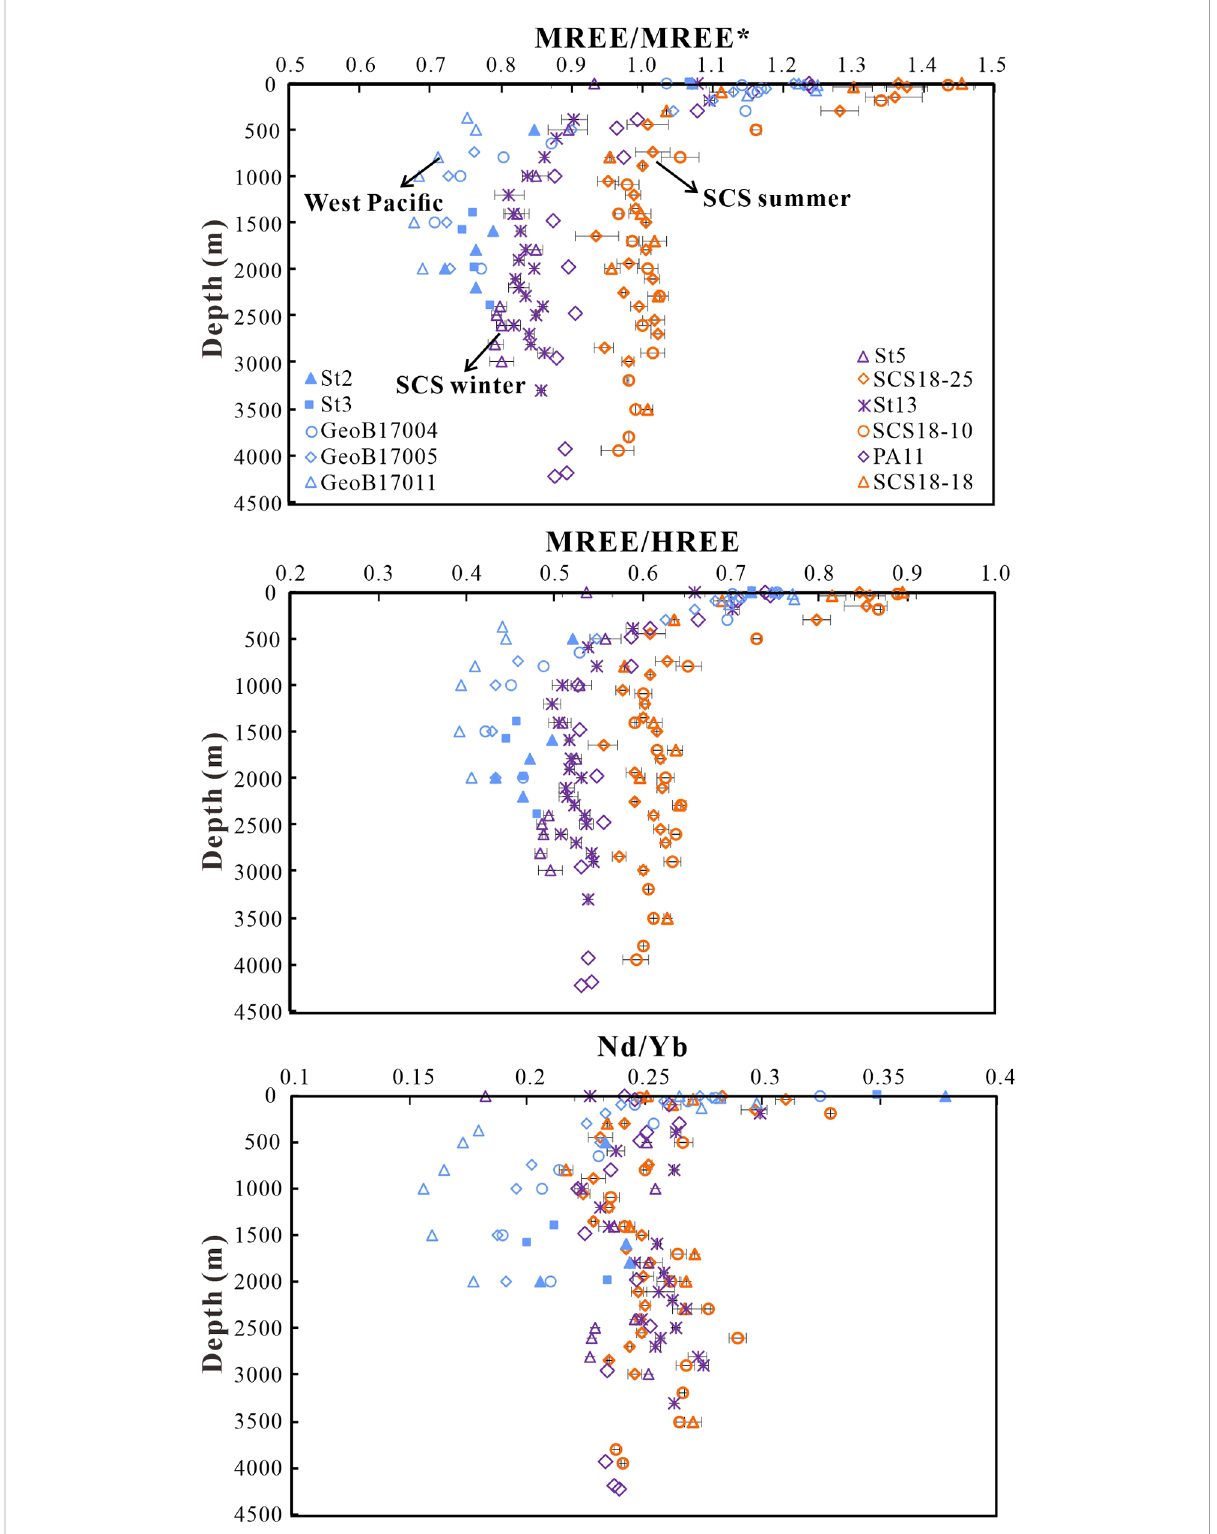
FIGURE 8 Vertical distribution of MREE/MREE*, MREE/HREE, and Nd/Yb ratios in the SCS (this study; Wu et al., 2015) and West Paci fi c (Behrens et al., 2018a). MREE/HREE is calculated using: MREE/HREE = (Gd + Tb + Dy)/(Tm + Yb +